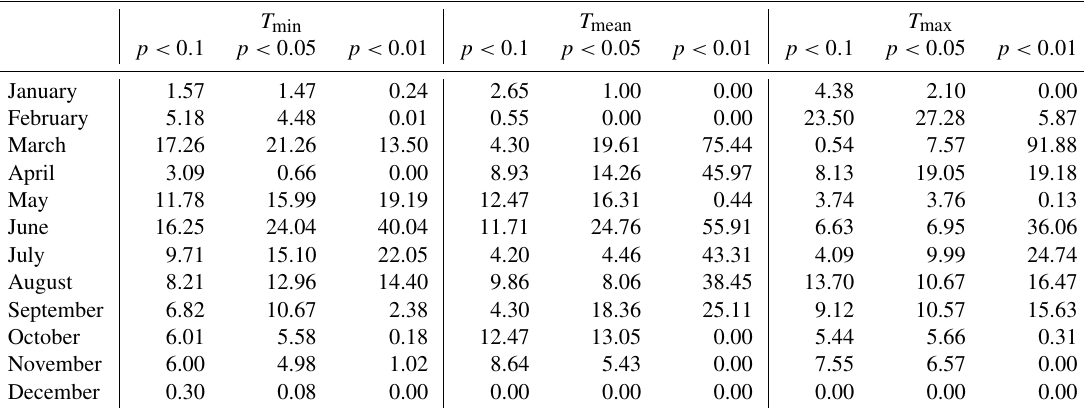
Table 2. Ratio (%) of grids at different significance levels ( p < 0 . 1, p < 0 . 05 and p < 0 . 01) to total grids (356133). T min T mean T max p < 0 . 1